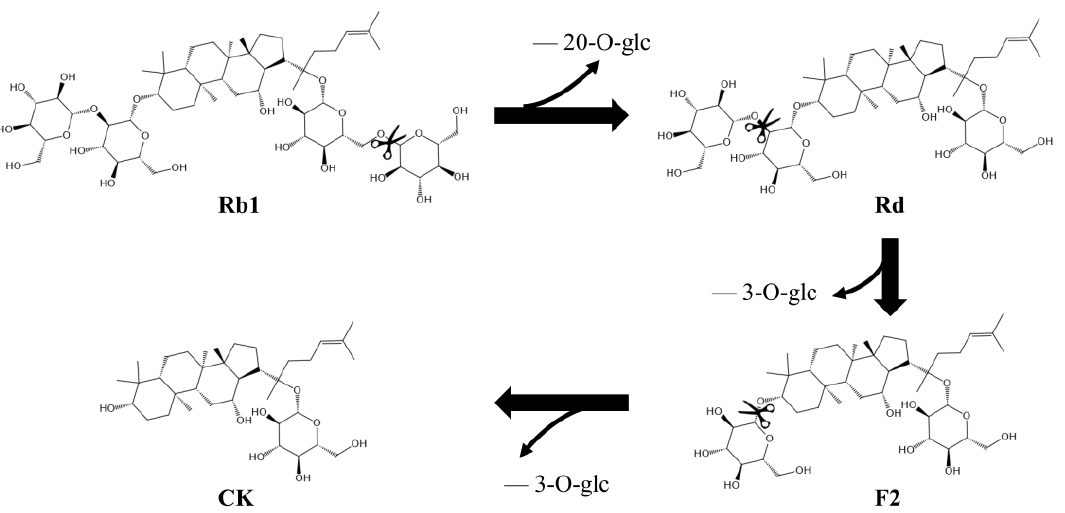
Figure 6. Biotransformation pathway from ginsenoside substrate into CK by the recombinant SS- bgly.